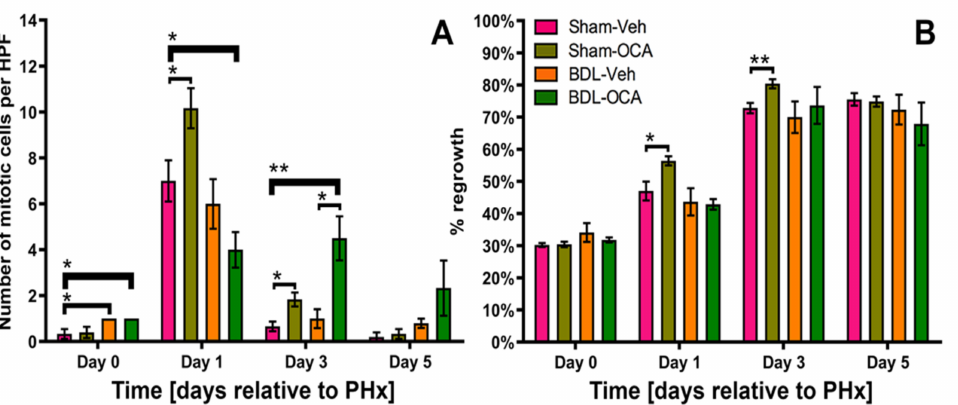
Figure 4. ( A ) Number of mitotic cells per high-power field (HPF) in the area with the highest mitotic activity at the time of PHx ( t = 0 days) and 1, 3, and 5 days after PHx. ( B ) Liver regrowth, expressed as percentage of dry remnant liver weight of the total dry liver weight, at the time of PHx ( t = 0 days) and 1, 3, and 5 days after PHx. All data points are provided as mean ± SEM. Significance was assessed using a Mann–Whitney U test. An additional comparison was made between Sham-Veh vs. BDL-Veh. * indicates p < 0.05; ** indicates p < 0.01. BDL, bile duct ligation; Veh, vehicle; OCA, obeticholic